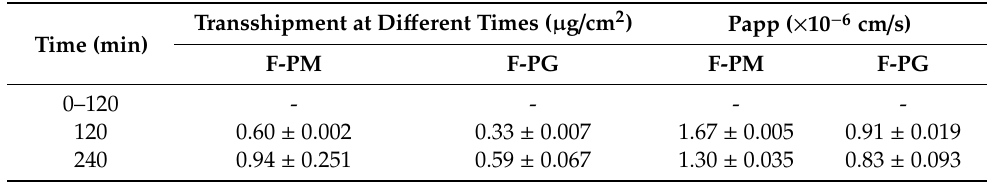
Table 7. The e ffl ux experiments with F-PM and F-PG.